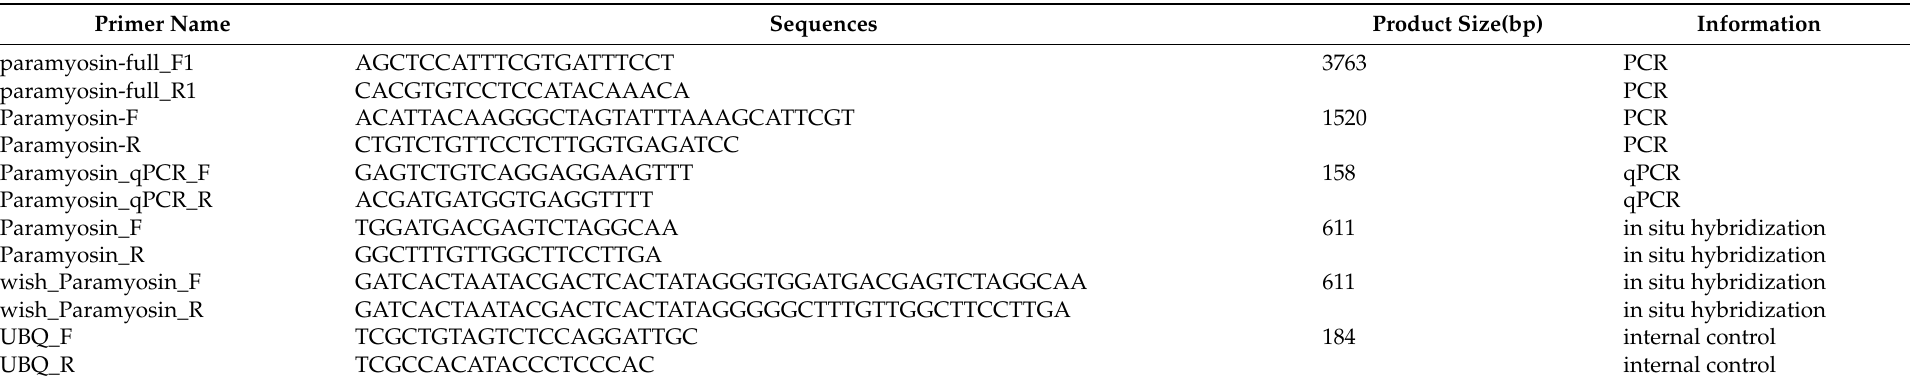
Table 1. The basic information on primers used in the